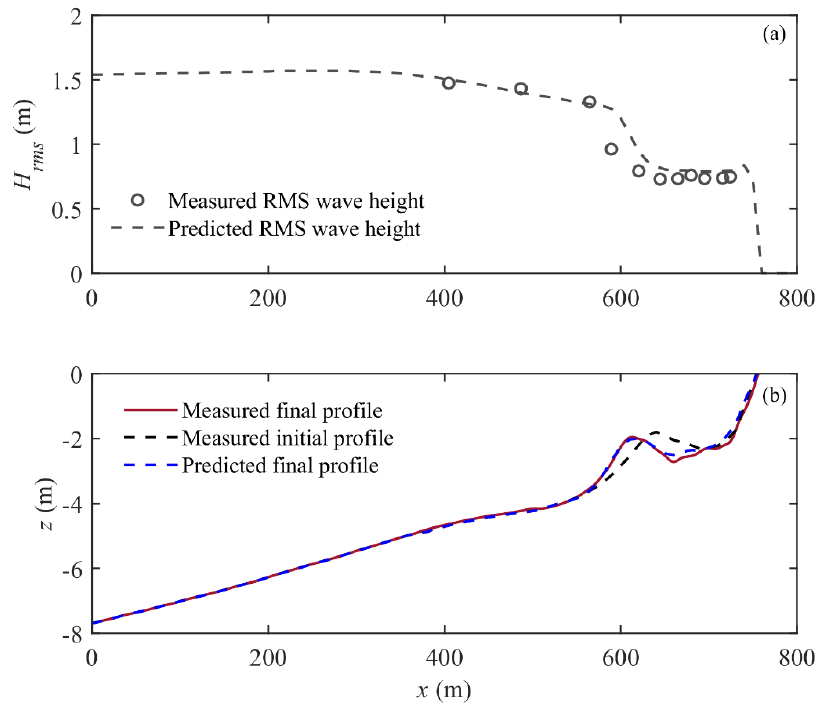
Figure 3. Comparison of ( a ) RMS wave height and ( b ) beach profile using a constant roller slope of 0.08.